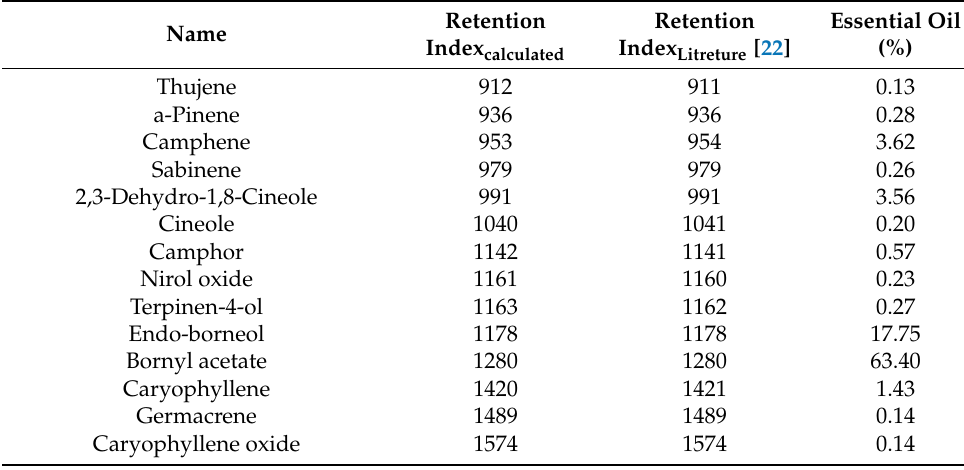
Table 1. The chemical ingredients of Artemisia jordanica essential oil .